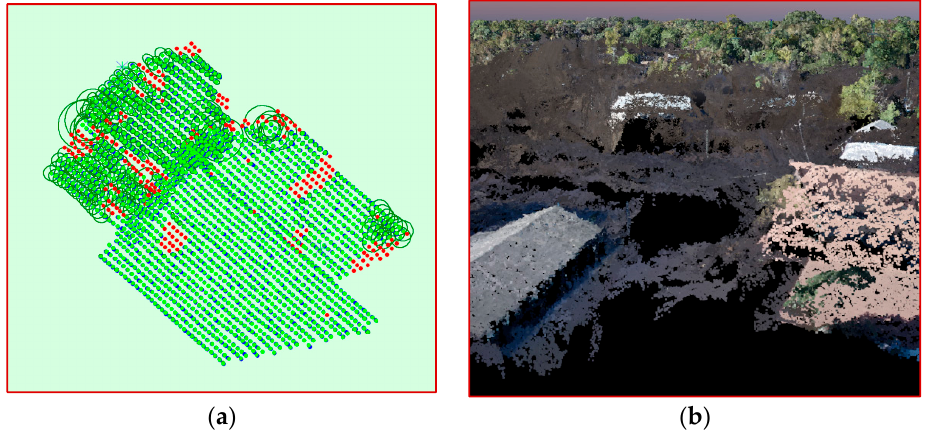
Figure 3. ( a ) Red points show the location of the images having calibration issues where selecting sufficient tie-points to reference the images was challenging due to the homogenous appearance of the water surface. ( b ) Initial point cloud includes considerable noise and artifacts.